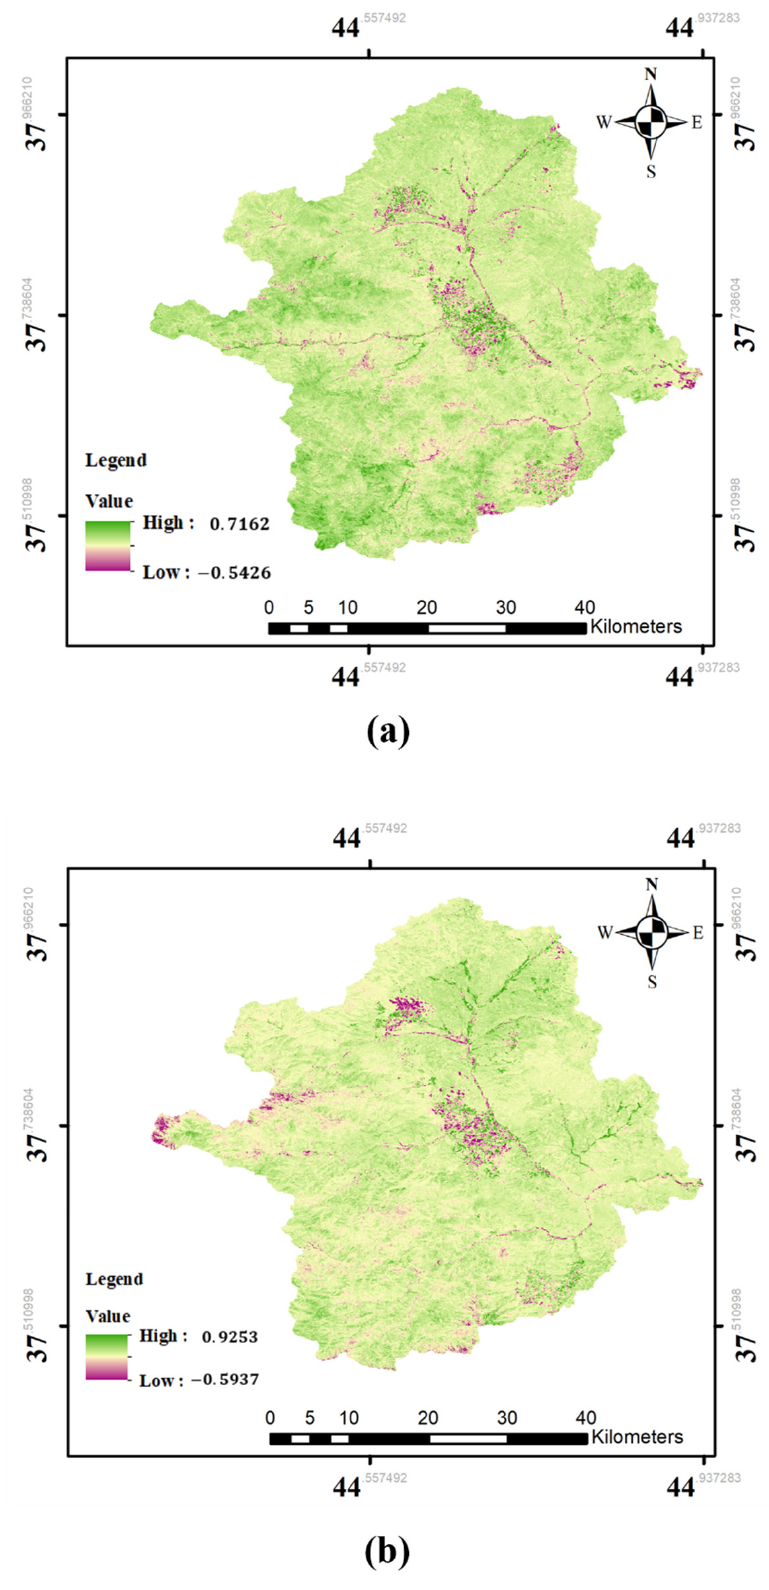
Figure 9. The pixel value change detection maps in the NC watershed between the averaged NDVI